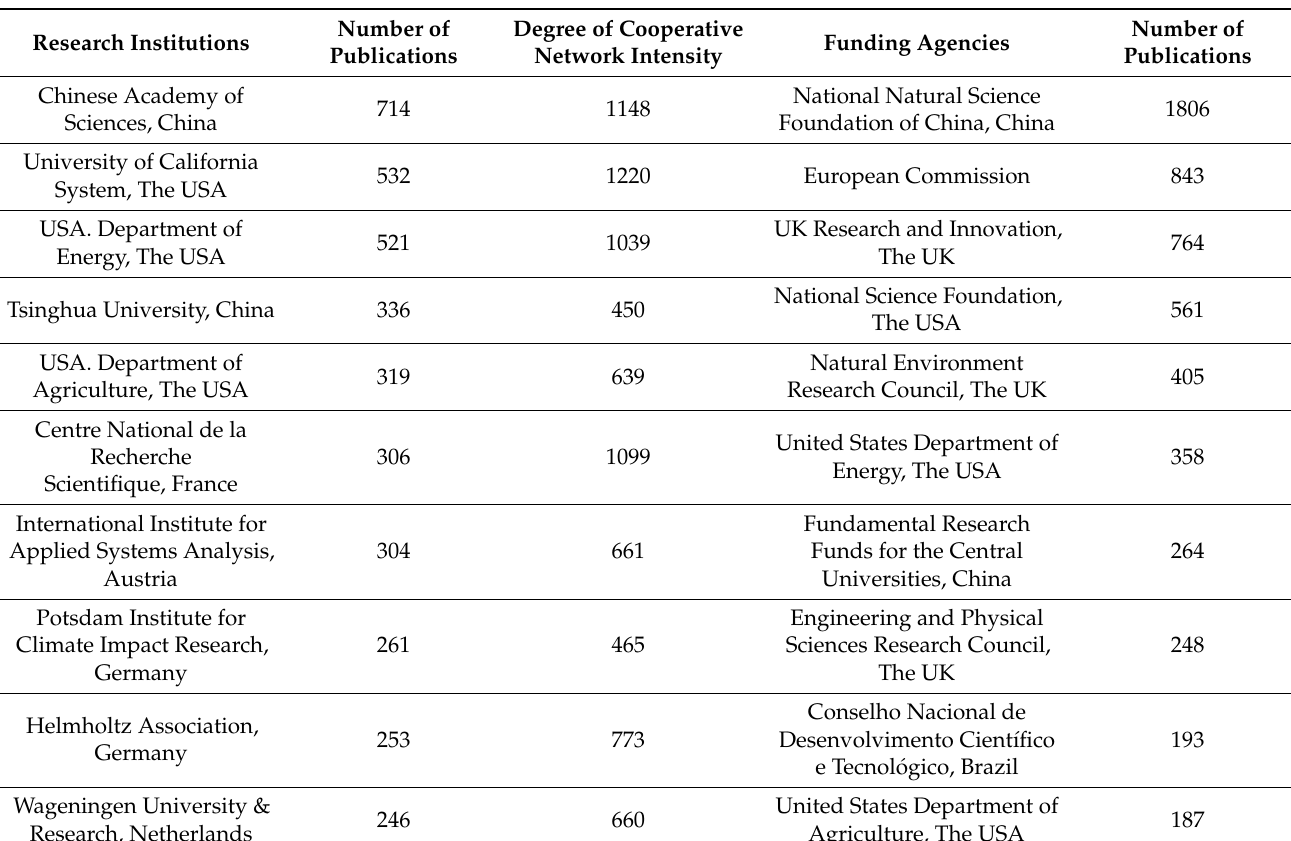
Table 2. Top Ten Research Institutions and Funding Institutions in the Field of Carbon Emission Reduction